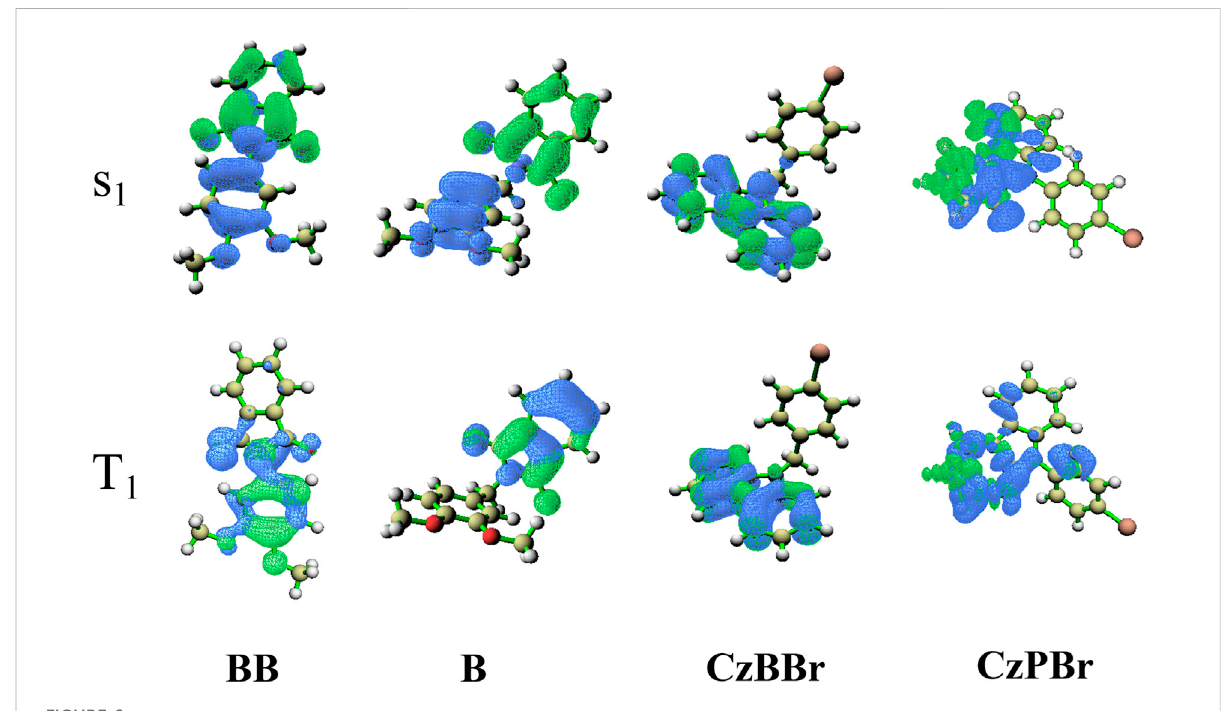
molecular structure, we calculated the dihedral Angle between donor and acceptor, as shown in Figure 1. In general, the dihedral Angle can re fl ect the degree of structural distortion of the material molecules. The dihedral angles of singlet S0 and fi rst excited triplet T1 of BB are 76.77 ° and 78.12 ° , and the variation between them is less than that of molecule B (the dihedral angles of S0 and T1 states of molecule B are 33.36 ° and 26.14 ° ). This indicates that the introduction of methylene is bene fi cial to inhibit molecular structural deformation. However, the dihedral angles of CzBBr and CzPBr are different. The dihedral angles of CzBBr in S0 and T1 states are 70.14 ° and 78.06 ° , and the dihedral angles of CzBBr in S0 and T1 states are 50.91 ° and 51.23 ° , respectively. The variation of dihedral Angle for S0 and S1 is consistent with that of S0 and T1. This indicates that the introduction of heavy atoms and methylene group has counteracting effect on the structural deformation. In order to quantitatively characterize the structural deformation during electron transition, we calculate the root mean square displacement (RMSD). RMSD (cid:1) . The changes and RMSD values between S0, S1 and T1 states of all molecules are shown in Figure 2. RMSD values of S0 vs. S1, S1 vs. T1 and S0 vs. T1 of molecular BB were 0.139, 0.052, 0.138, respectively. The RMSD values of S0 vs. S1, S1 vs. T1 and S0 vs. T1 states of molecule B are 0.149, 0.109 and 0.089 respectively,